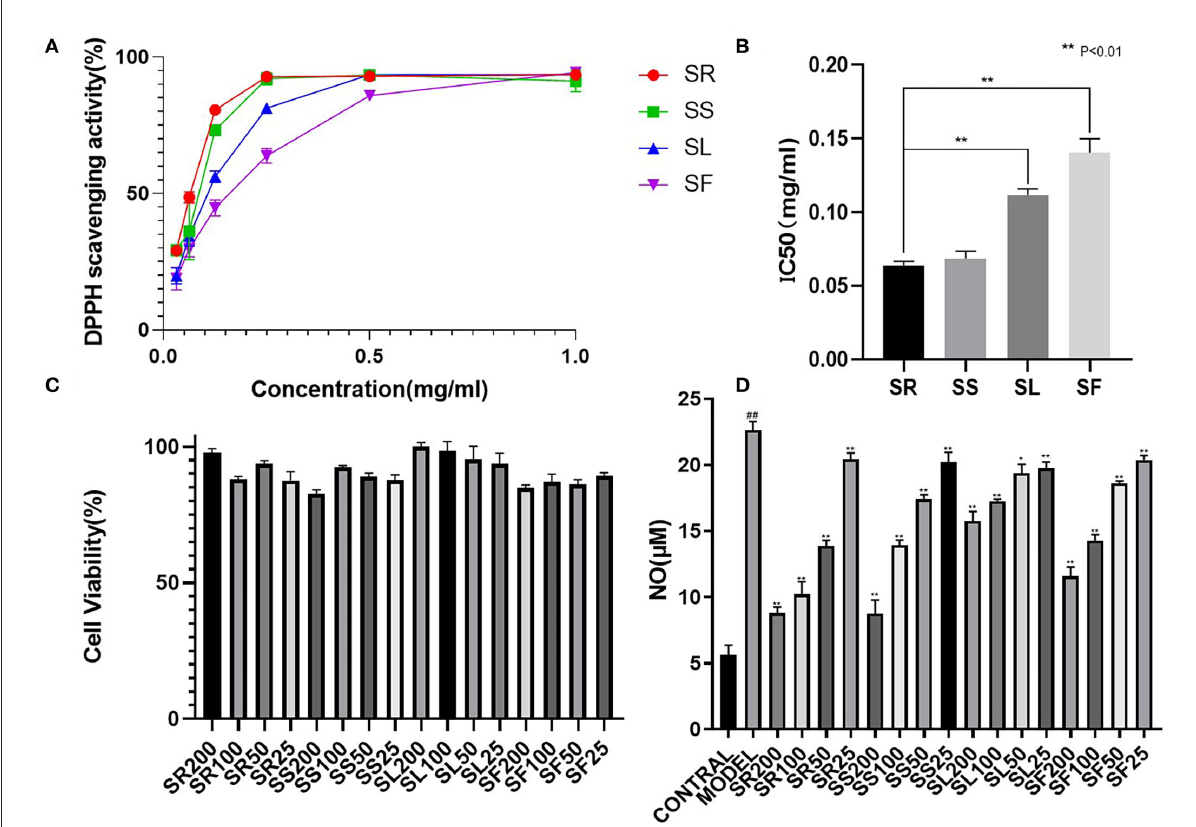
FIGURE6 Comparative 2,2 ′ -diphenyl-1-picrylhydrazyl (DPPH) scavenging capacity and anti-inflammatory activity of S. chinensis. (A) DPPH scavenging activity of different plant parts. (B) The half maximal inhibitory concentration (IC 50 ) values of different plant parts. (C) Cell viability of different plant parts. (D) Anti-inflammatory activity of different plant parts. The results were expressed as the mean experiments were performed for each